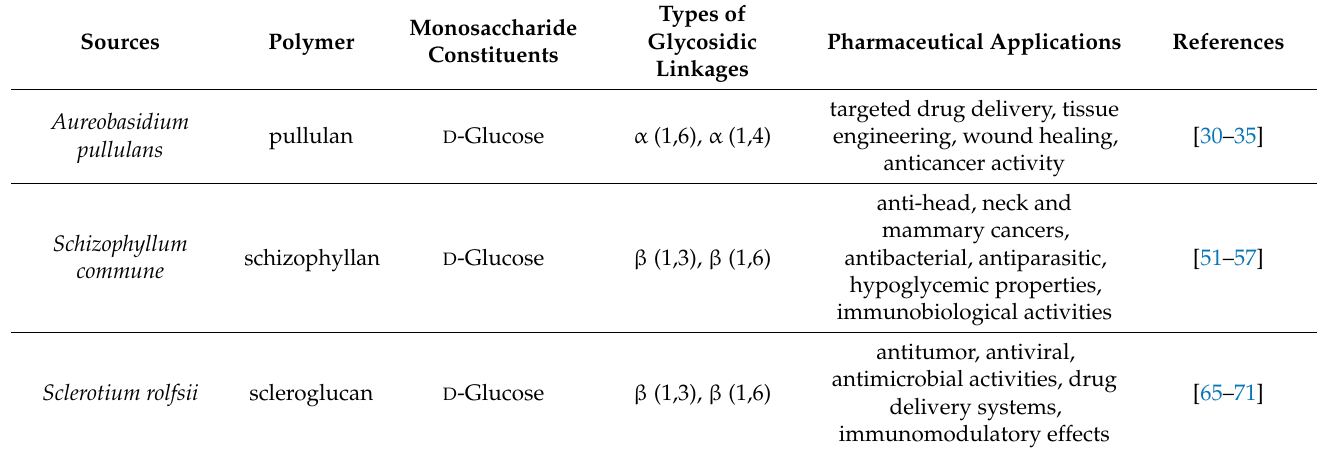
Table 1. Some fungal polysaccharides with pharmaceutical